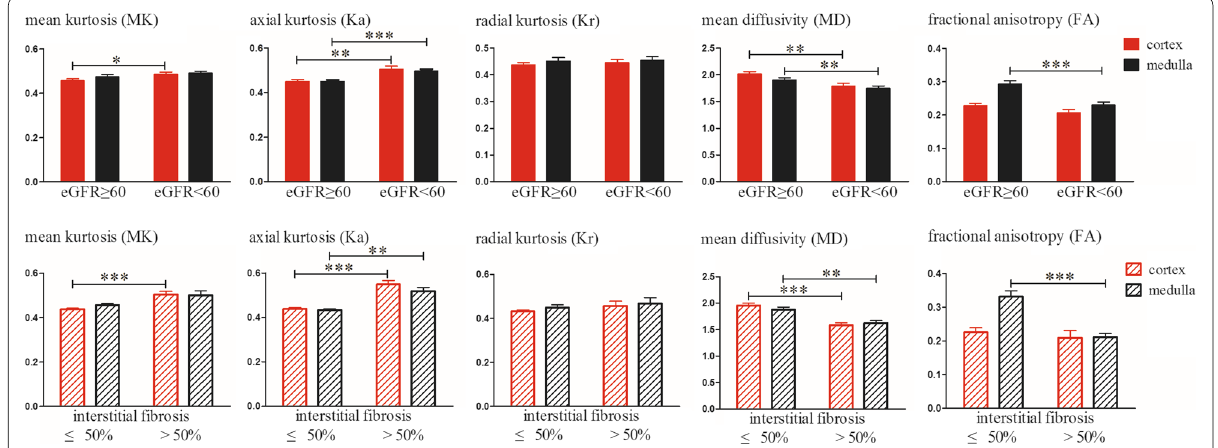
Fig. 3 Diffusion kurtosis imaging (DKI) metric values in renal cortex and medulla between patients with different degrees of renal dysfunction and interstitial fibrosis. There were significant differences on cortical MK, parenchymal Ka, MD and medullary FA between the two groups. * p < 0.05, ** p < 0.01, *** p <